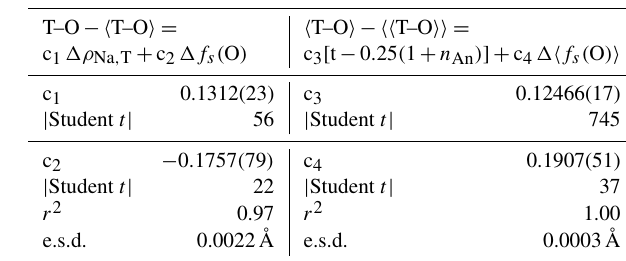
Table 2. Results of the regression analyses according to Eqs. (7) and (8). Errors given in parentheses refer to the last decimal